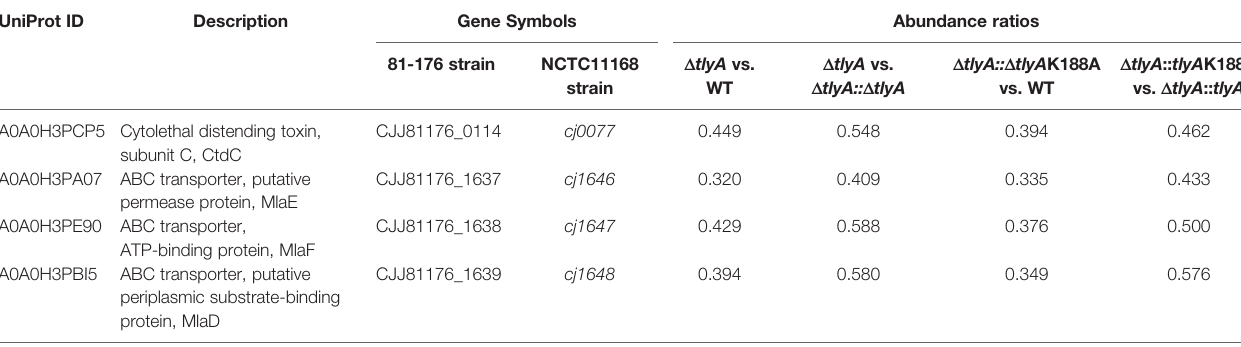
TABLE 3 | Signi fi cant differences in the proteome of C. jejuni in the various TlyA + versus TlyA - strain comparisons. UniProt